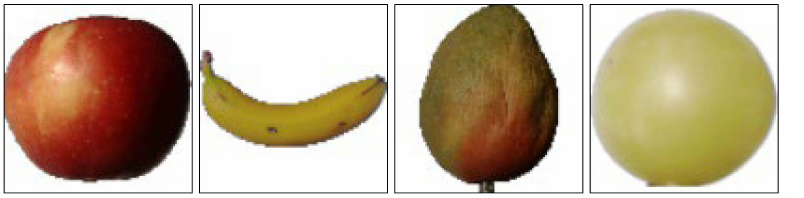
Figure 4. Example images of Fruits-360 dataset used in our experiment. Left to right: images of apple, banana, peach, and grape.